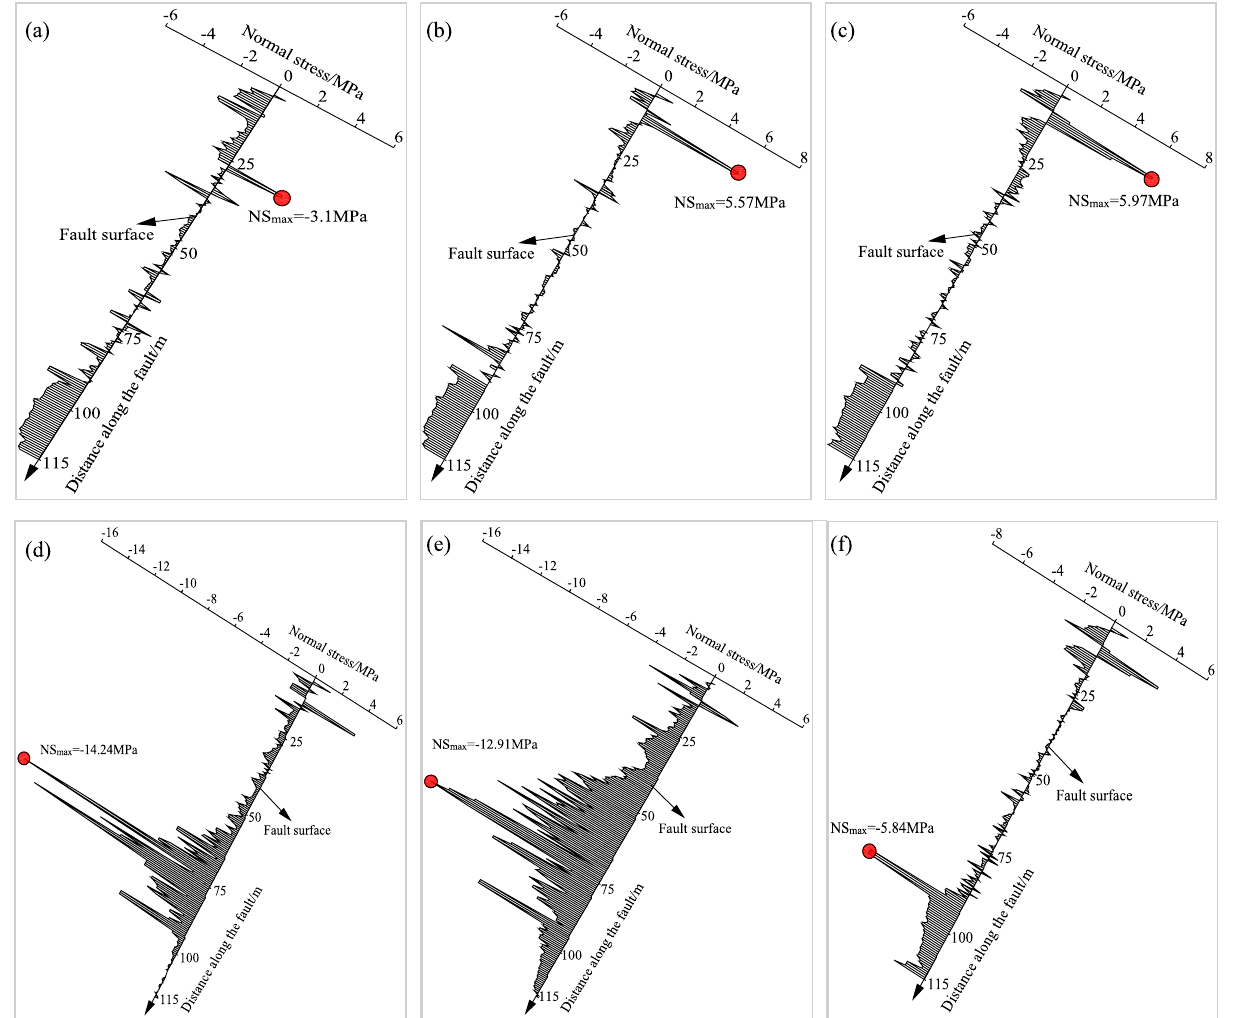
Figure 16. Evolutionary process of the normal stress along the fault plane under different roadway formation